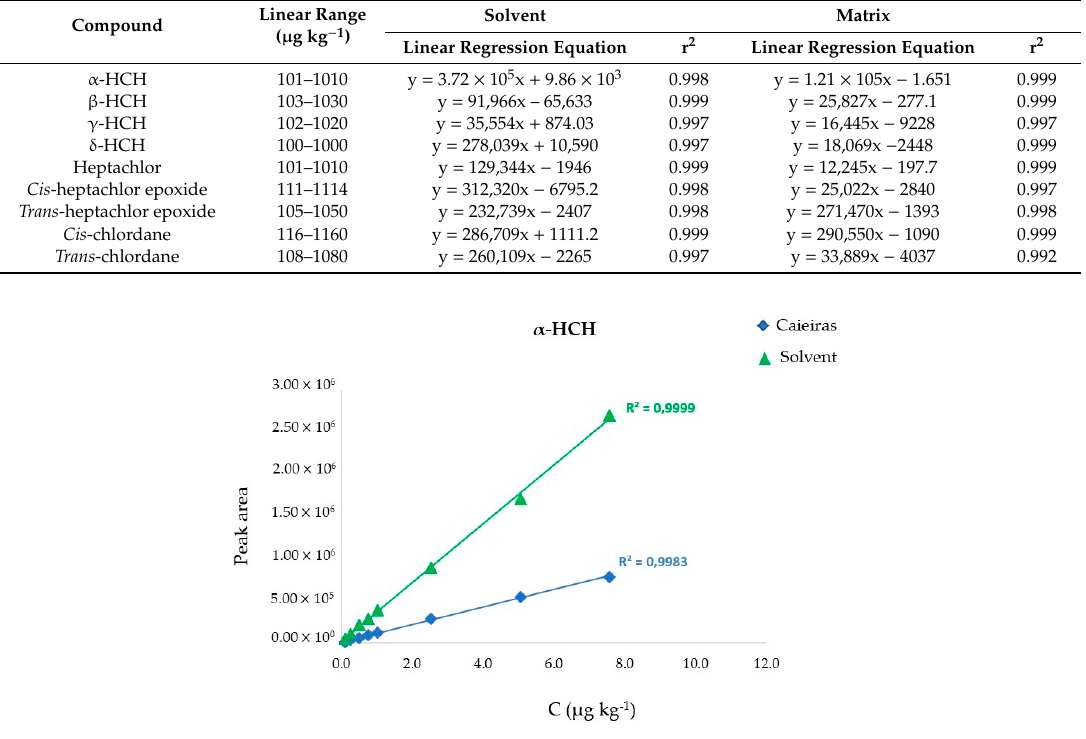
Figure 4. Analytical curves of α -HCH in ACN solvent and soil matrix.